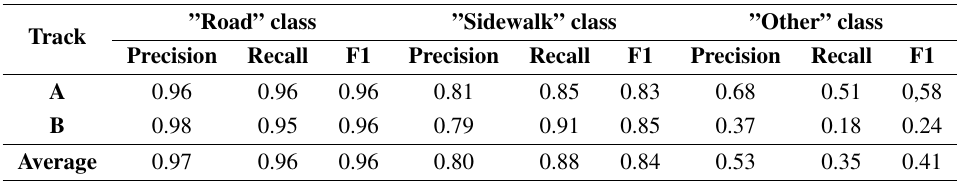
Table 2. Performance values of the semantic segmentation method, in terms of Precision, Recall and F1-score. Track